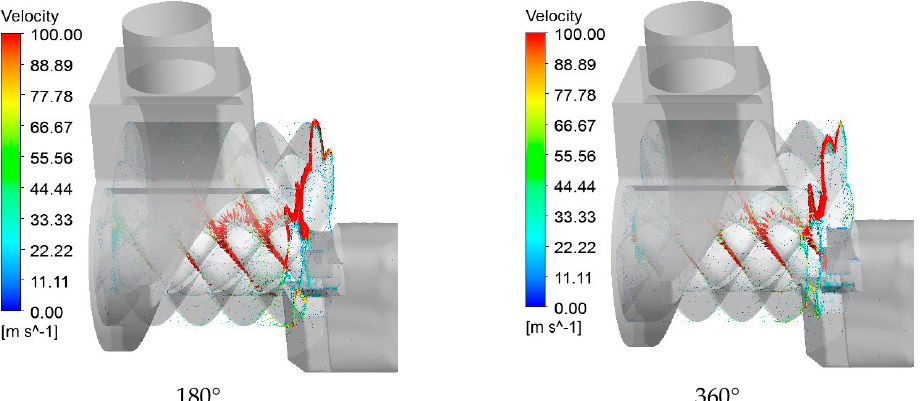
Figure 12. The leakage velocity vector of the compressor at different angles.